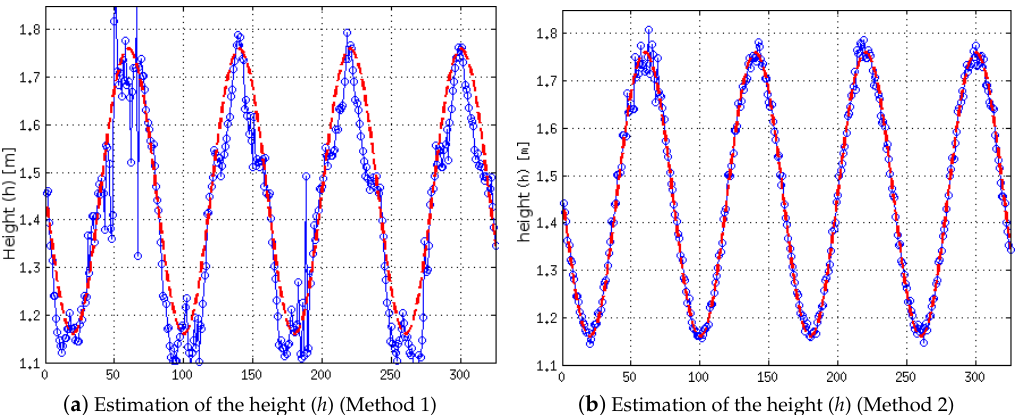
Figure 10. Result of the self-calibration of the height ( h ) for non-negligible values of the roll angle. Estimated values appear in blue and the ground truth in red.